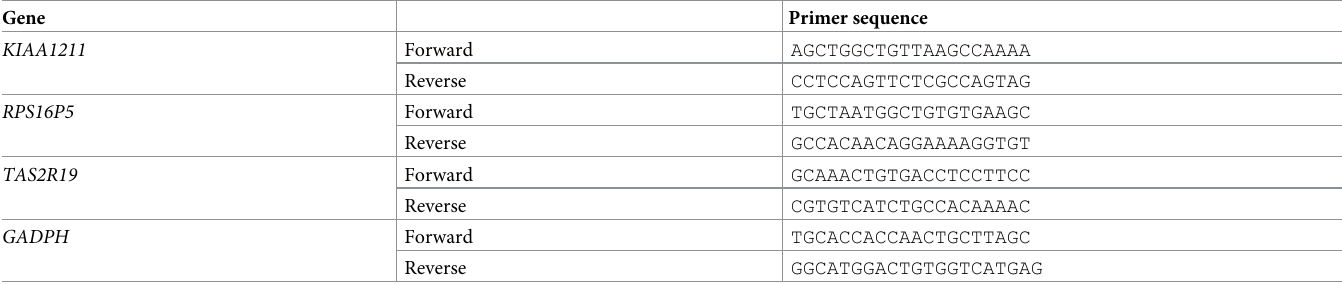
Table 1. List of primers used in the current